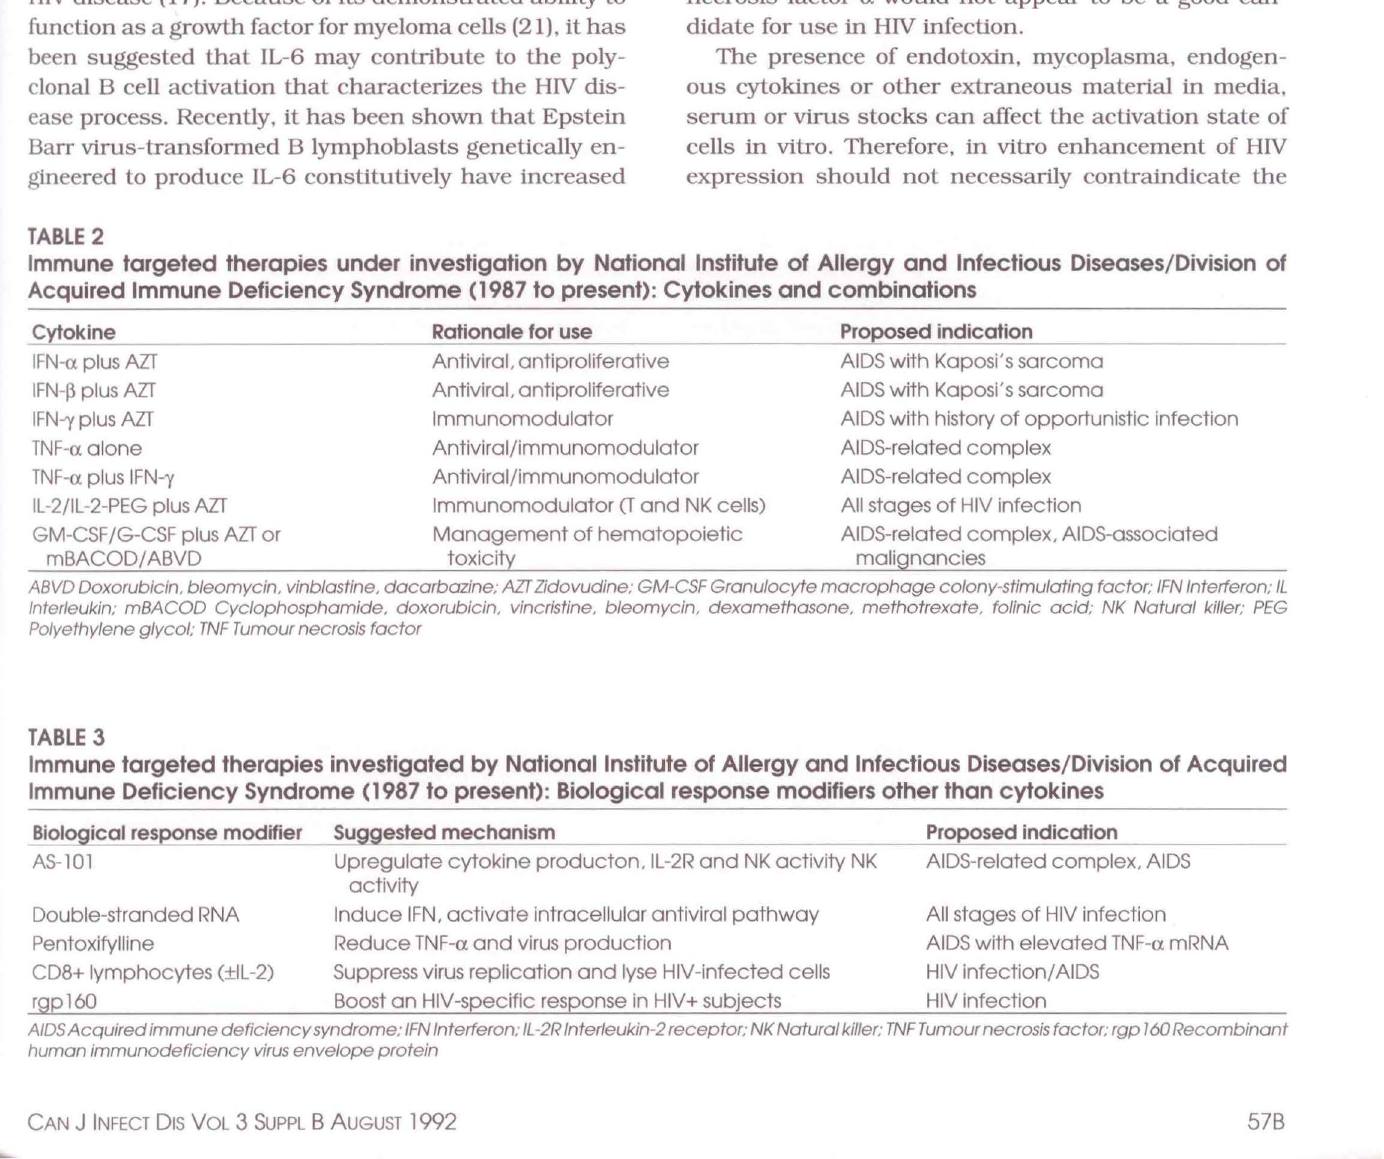
Acquired Immune Deficiency Syndrome (1987 to present): Cytokines and combinations